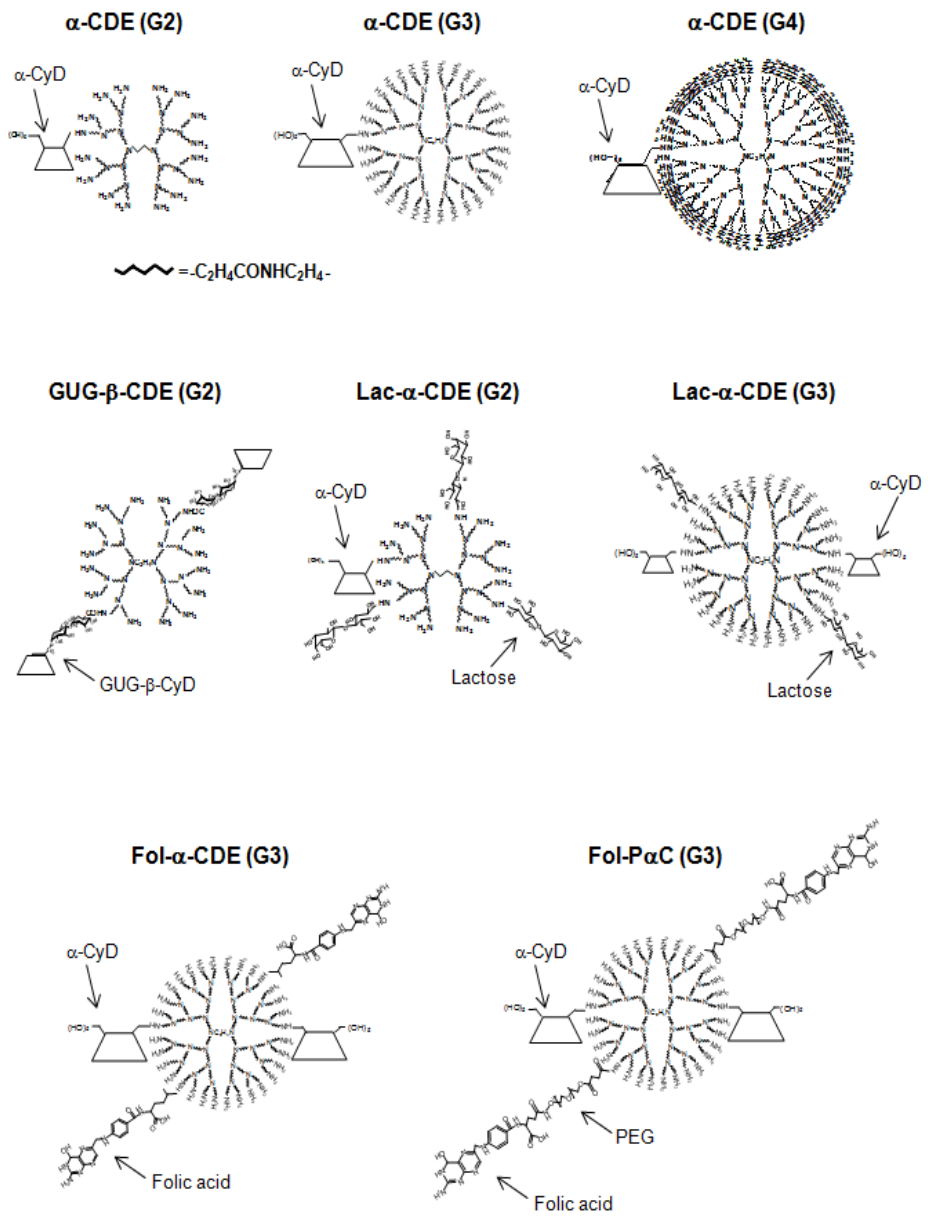
Figure 1. Chemical structures of various cyclodextrin/dendrimer conjugates (CDEs) used in this